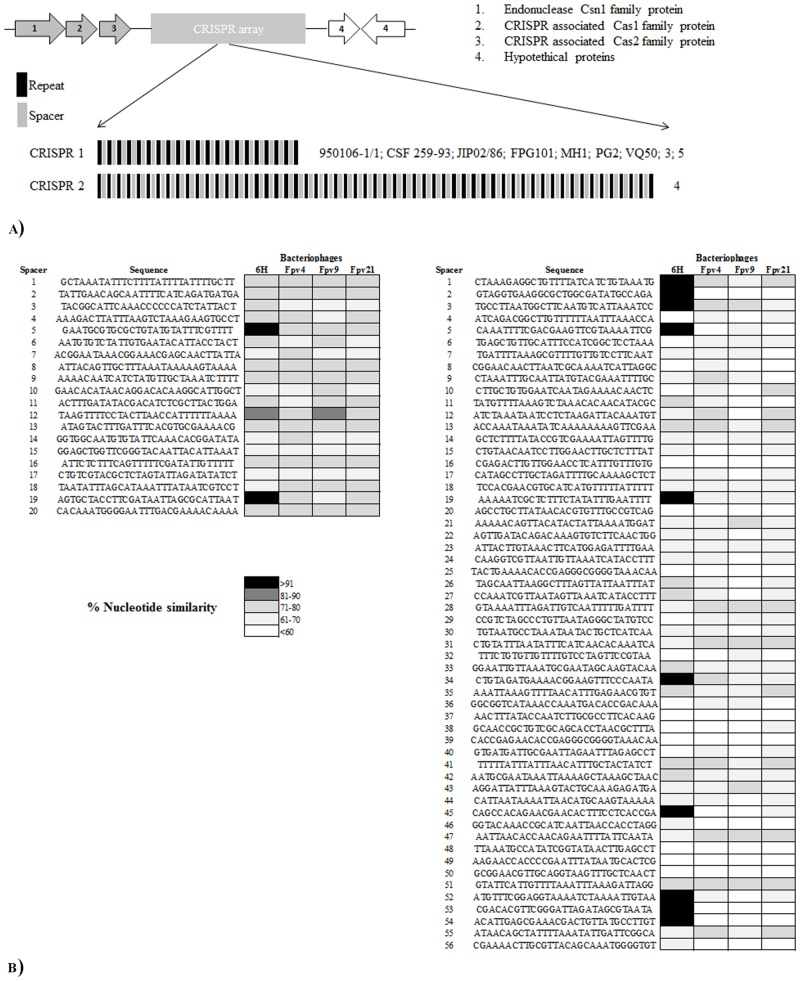
F. psychrophilum isolates CRISPRs overview.A) Graphic representation of cas genes, spacer and repeats of CRISPR1 and CRISPR2 in the F. psychrophilum isolates. B) Nucleotide comparison of spacers from CRISPR1 (left) and CRISPR2 (right) against genome sequences from bacteriophages 6H, Fpv4, Fpv9 and Fpv21.